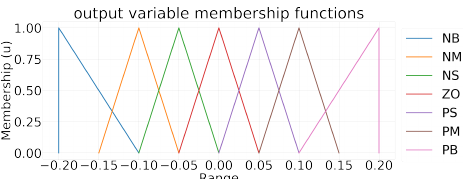
Figure 16. Output Membership Function for the I Gain